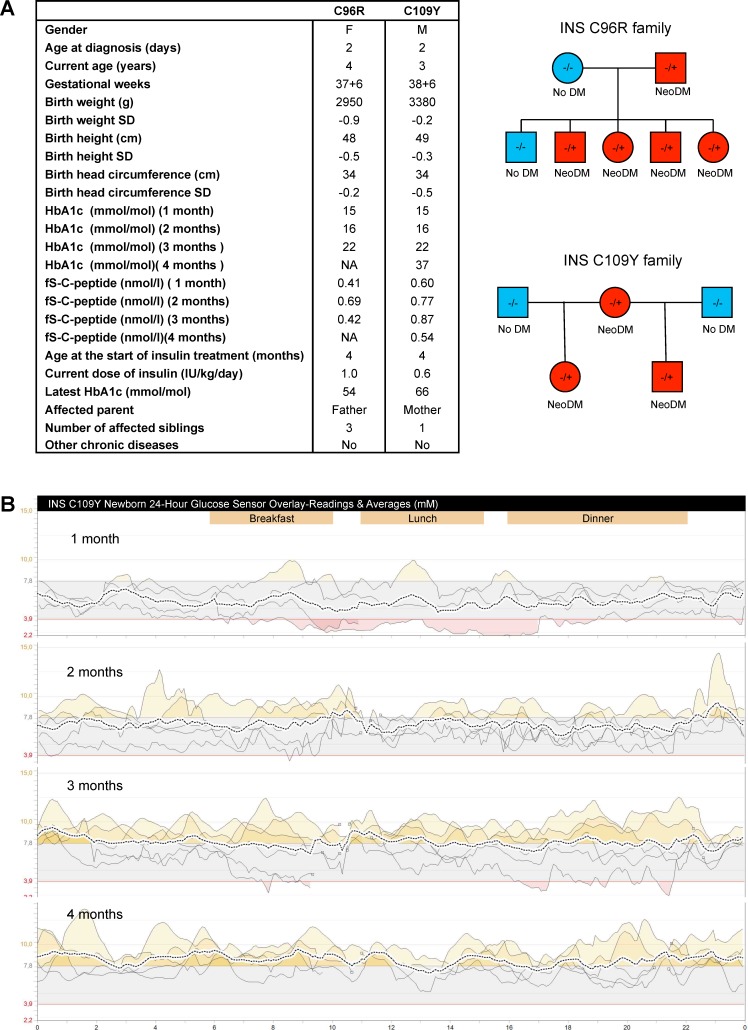
Clinical history of the people carrying insulin gene mutations.(A) Clinical characteristics and family pedigree of the people carrying insulin gene mutations C96R and C109Y. NeoDM = Neonatal Diabetes Mellitus. (B) Glucose sensor readings and averages of the newborn carrying the C109Y mutation.